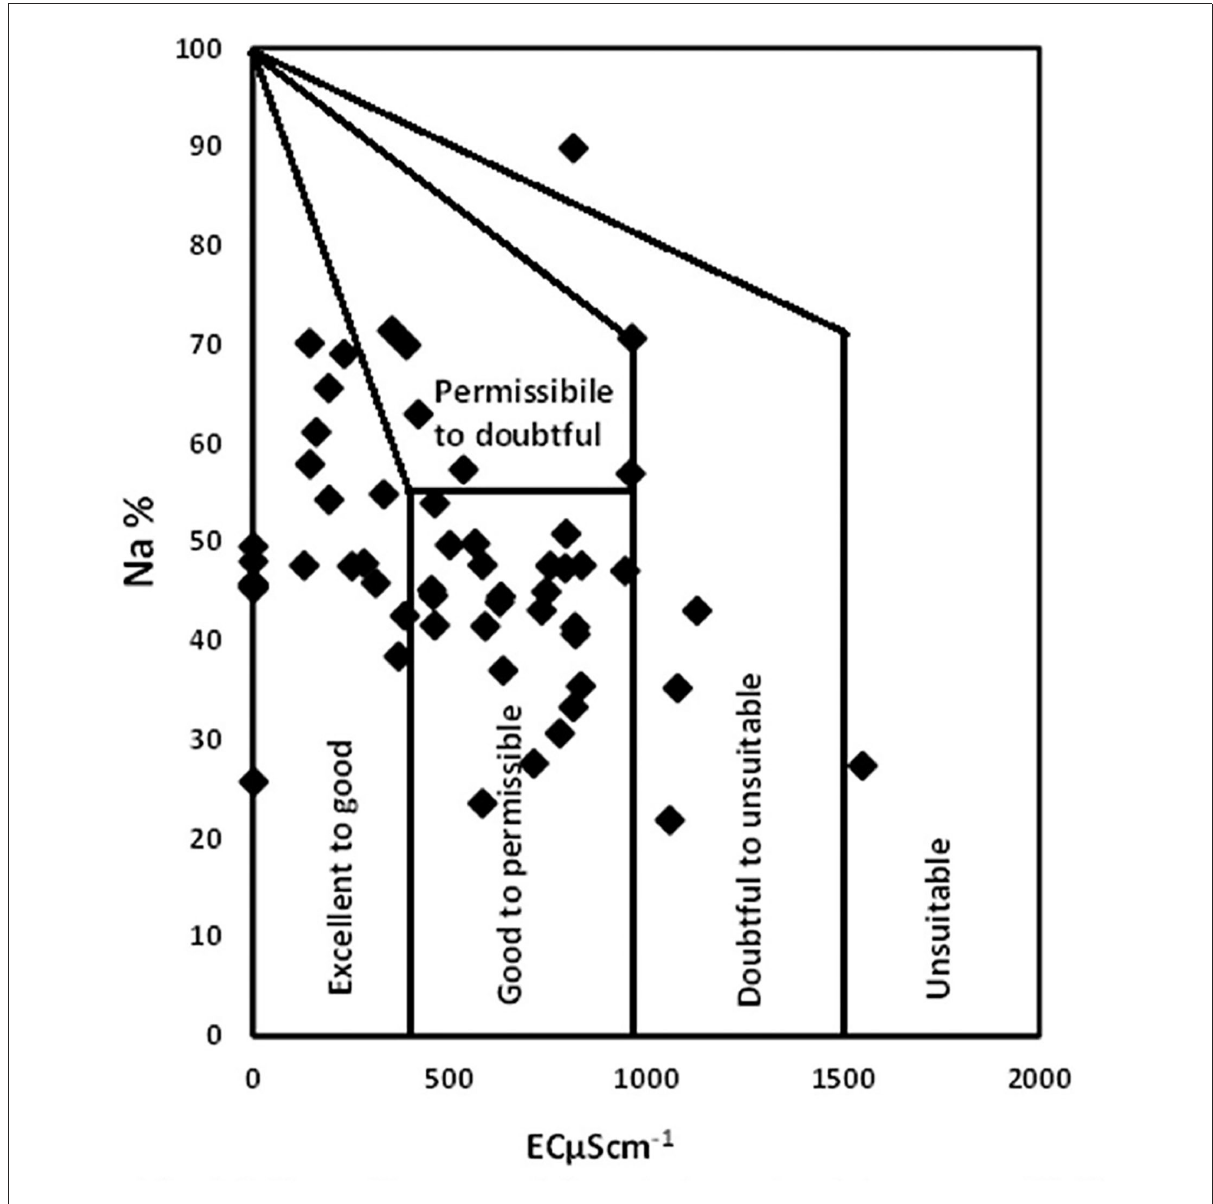
FIGURE7 Wilcox diagram of electrical conductivity vs.